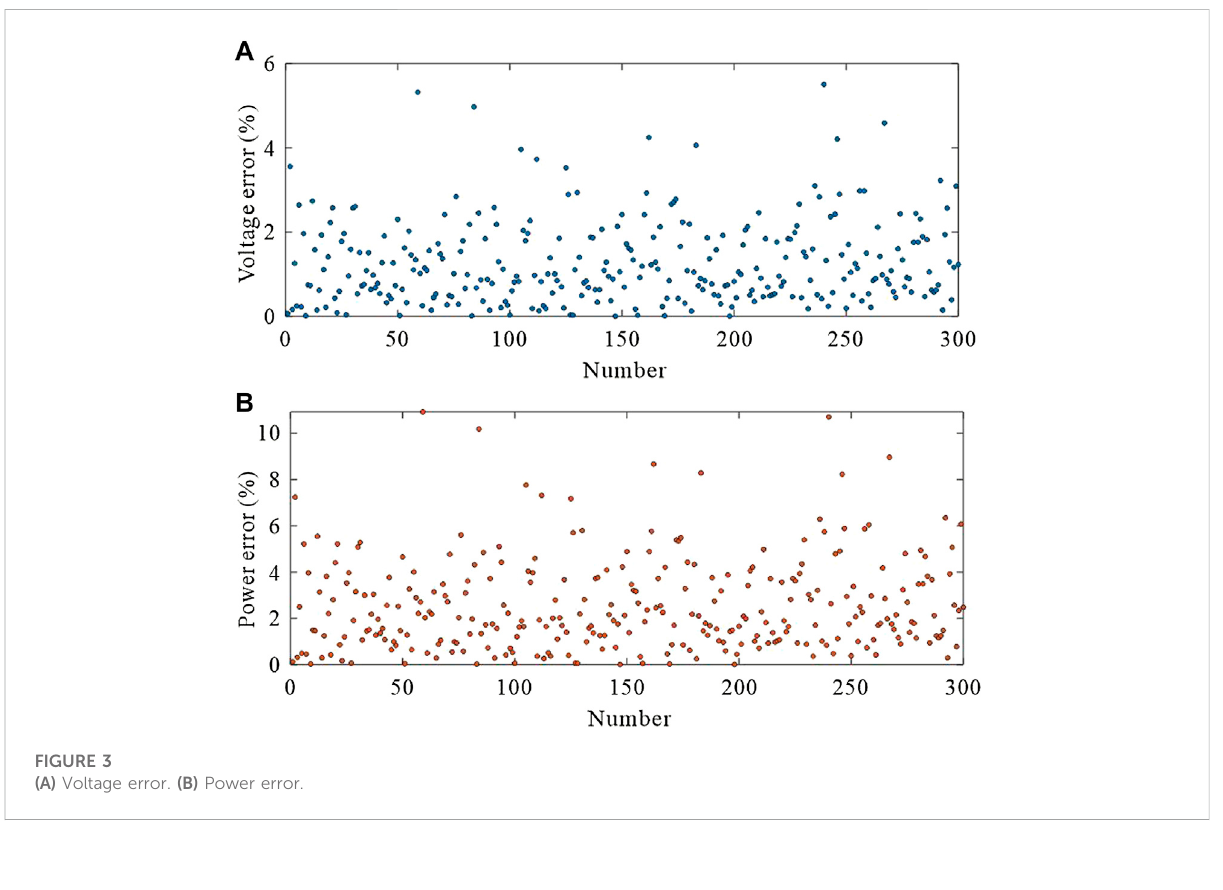
FIGURE 3 (A) Voltage error. (B) Power